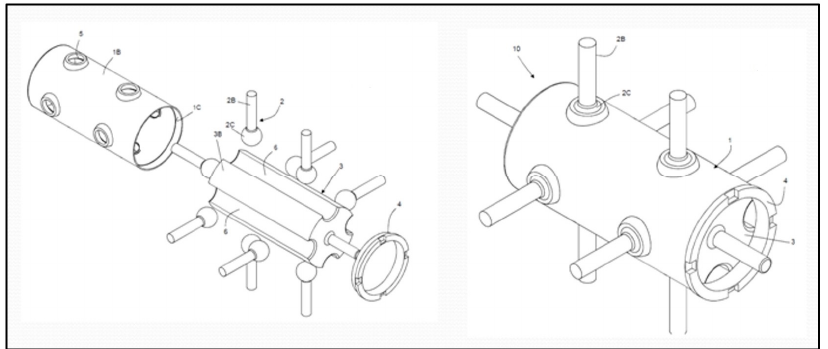
Figure A4. Scheme of the universal structural node, patent PR2013A000019. Vestrut [29]